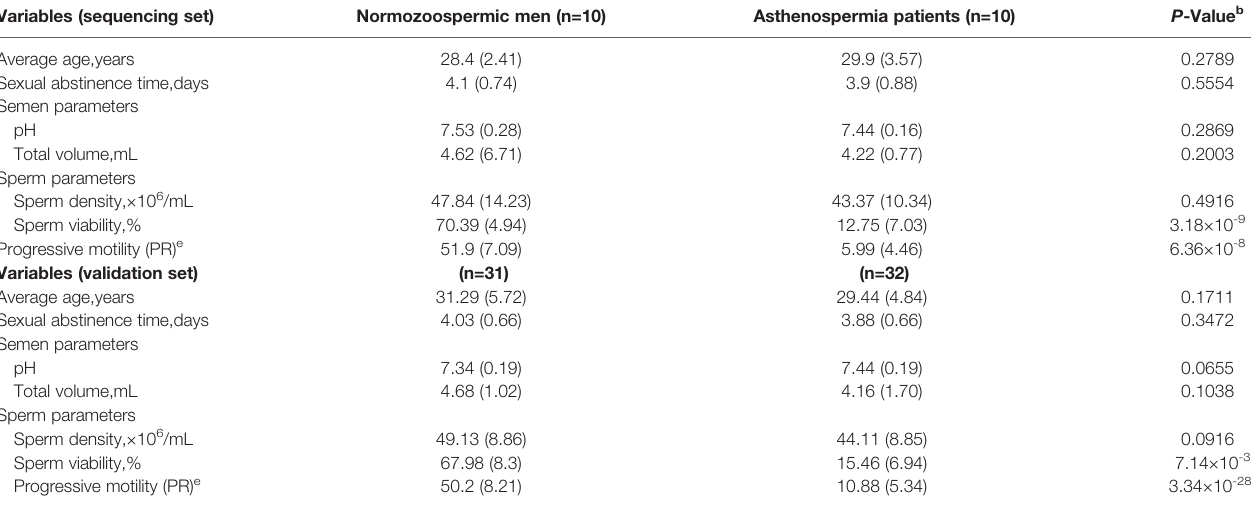
TABLE 1 | Demographic and clinical features of the Asthenospermia patients and normozoospermic men a . Variables (sequencing